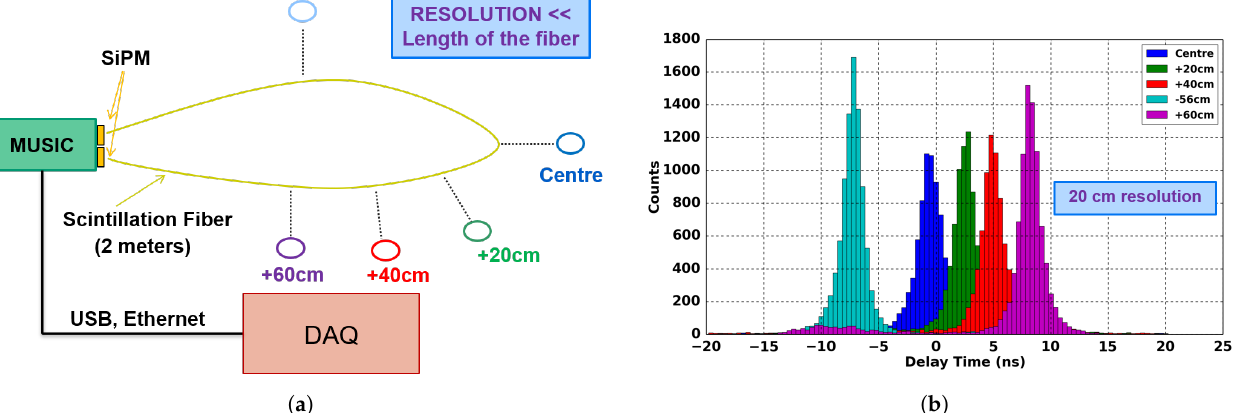
Figure 16. Beam Loss Monitor (BLM) employing the MUSIC ASIC, a scintillator fiber and two Hamamatsu SiPMs S13360 − 3050CS. ( a ) BLM diagram showing different locations where a radioactive source (gamma photons) was placed to interact with the plastic fiber; ( b ) CTR with PZ